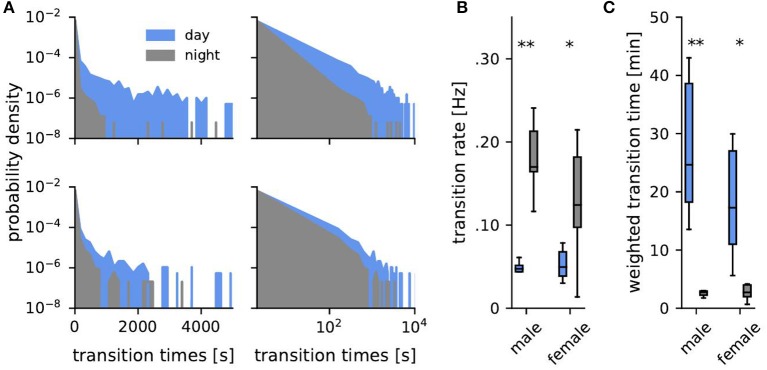
Transition times. (A) Probability density of transition times (time span spent consecutively within one habitat) during the day (blue) and the night (gray) for one example male (top, fish ID 4) and female (bottom, fish ID 10). (B) Corresponding transition rates obtained from fitting an exponential to the distributions of transition times. (C) Averaged weighted transition times (Equation 2). Asterisks indicate significant differences: **p < 0.01 and *p < 0.05.